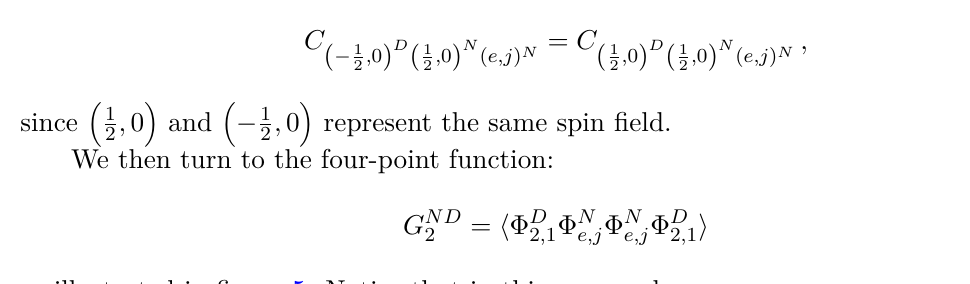
Figure 4 . The s - and t -channels of the four-point function h Φ D (cid:0) 1 (cid:1) (cid:0) (cid:1) since , 0 and − 1 , 0 both represent the same spin field, we obtain the structure constants 2 2 C in the s -channel and C ( − 1 , 0 ) D ( 1 , 0 ) N ( e,j ) N 2 2 fields with e → e + 1